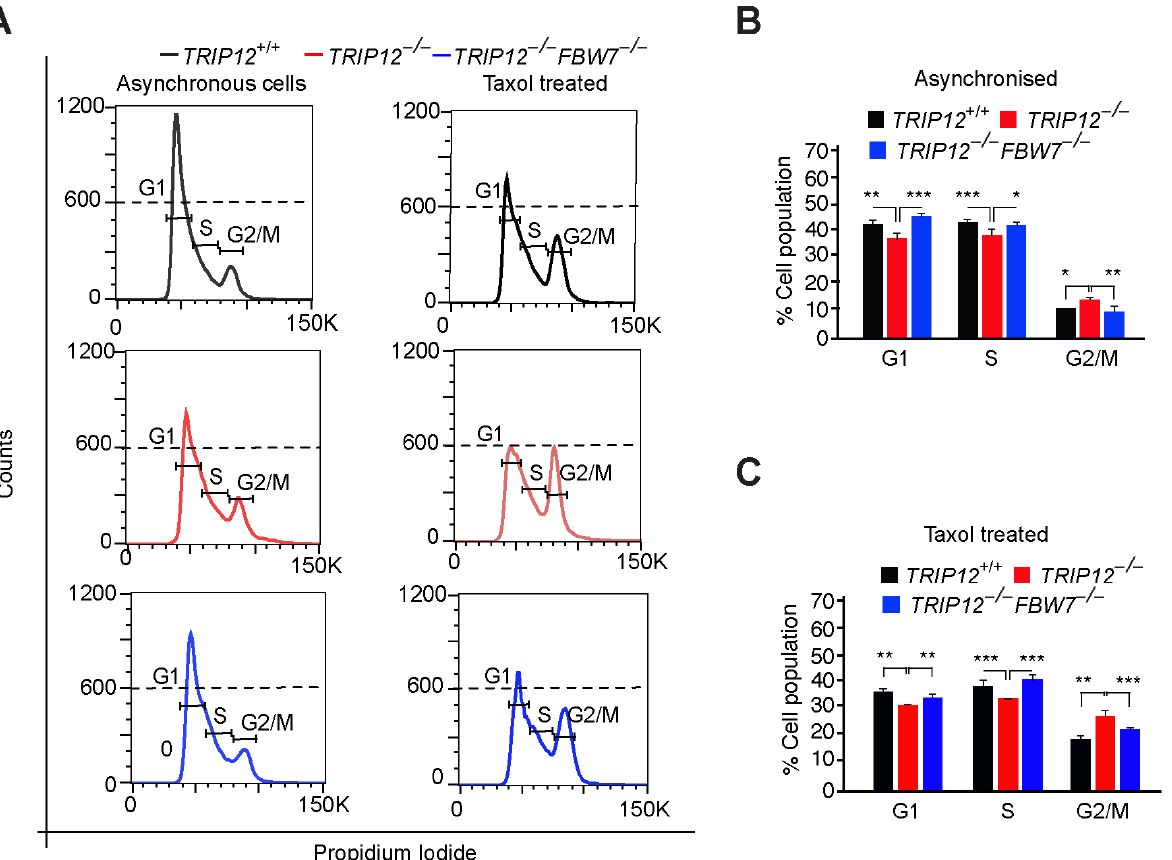
Figure 2. Enhanced mitotic arrest in TRIP12 -depleted cells: ( A ) Histogram of asynchronously grow– ing and Taxol treated HCT116 cells with indicated genotypes. Following treatment with Taxol, cells were collected, fixed, and stained with Propidium iodide (PI), and the DNA content was analyzed by FACS. ( B , C ) Quantification of fluorescence intensity of the PI-stained DNA in a population of cells within distinct cell-cycle phases from A. Mean ± S.D. of 3 independent experiments is shown. * p < 0.05, ** p < 0.01, and *** p < 0.001.